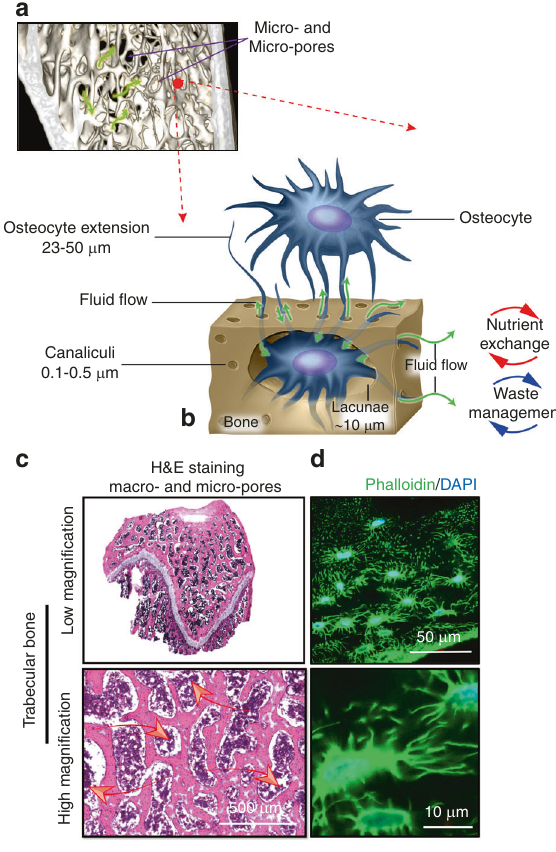
Fig. 1 A multilayered porous system in bone allows for dynamic fl uid fl ow (green arrows) at the nano, micro- and macroscale. a A microCT image of healthy murine trabecular bone. The bone structure consists of micro- and macropores. b A schematic demonstrating osteocytes within the LCS. c Representative photo- micrographs of a longitudinal section prepared from the distal femur of a healthy rat. The pores are inhabited by bone marrow containing blood vessels and multiple cell groups. The pores provide an environment for fl uid movement (red arrows) and the generation of fl uid-induced cellular mechanostimulation. d Representative images of osteocytes within the LCS. The osteocyte nucleus (blue) and cell processes (green) are observed within the canaliculi and allow communication between cells that are located at distant sites. Images were taken from cryo-sections prepared from healthy rat bone. Not presented are the vascular porosities within the Volkmann and Haversian canals, which provide an additional pore structure, as well as the collagen-hydroxyapatite porosities, which comprise the smallest pore size in